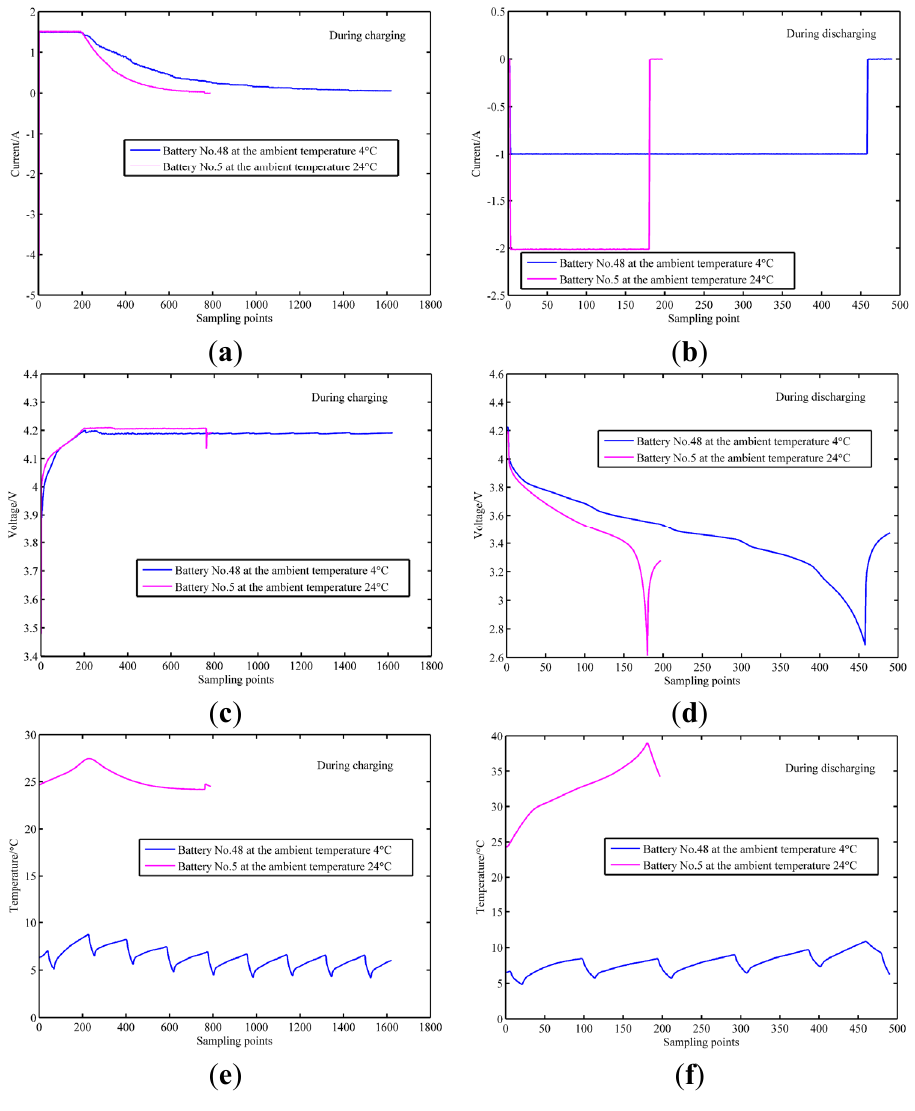
Figure 2. Charging and discharging conditions of Batteries No. 5 and 48: ( a ) current during charging; ( b ) current during discharging; ( c ) voltage during charging; ( d ) voltage during discharging; ( e ) temperature during charging; and ( f ) temperature during